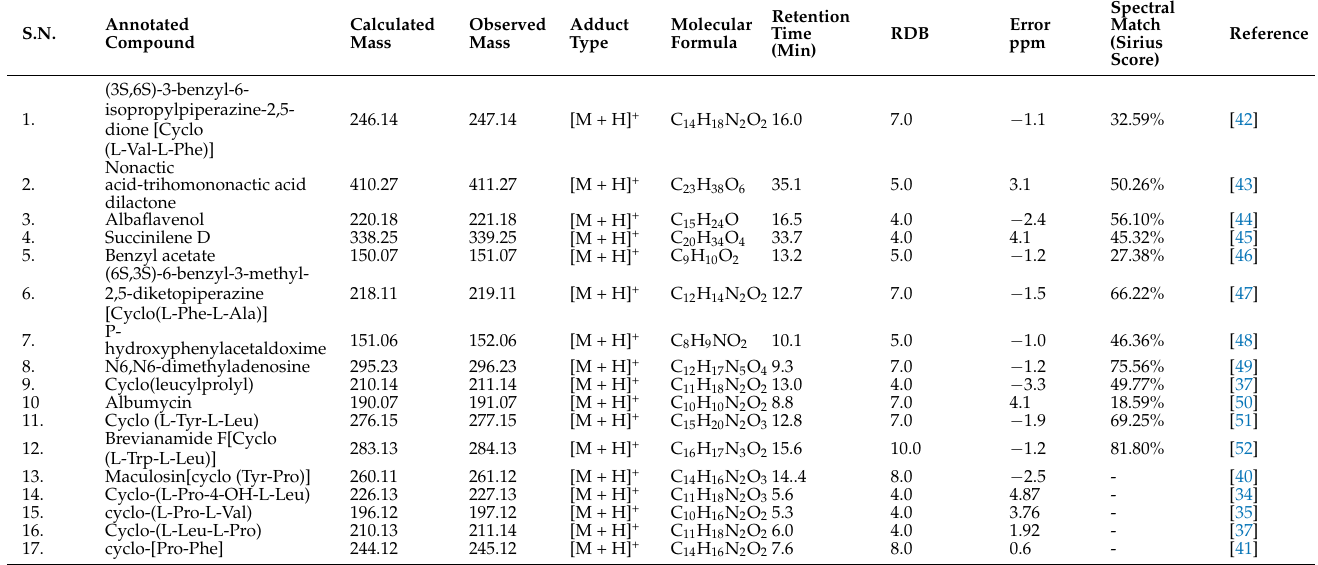
Table 4. Annotated compounds from the ethyl acetate extract of S. species SB10.